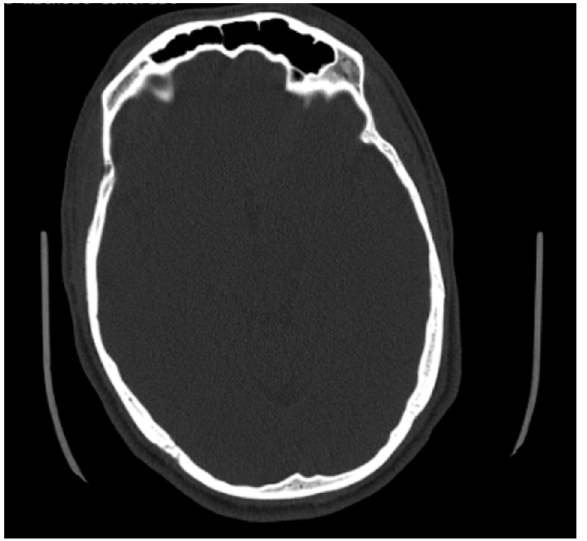
Figure 7. Example of an axial CT image slice useful for measuring frontal sinus depths.